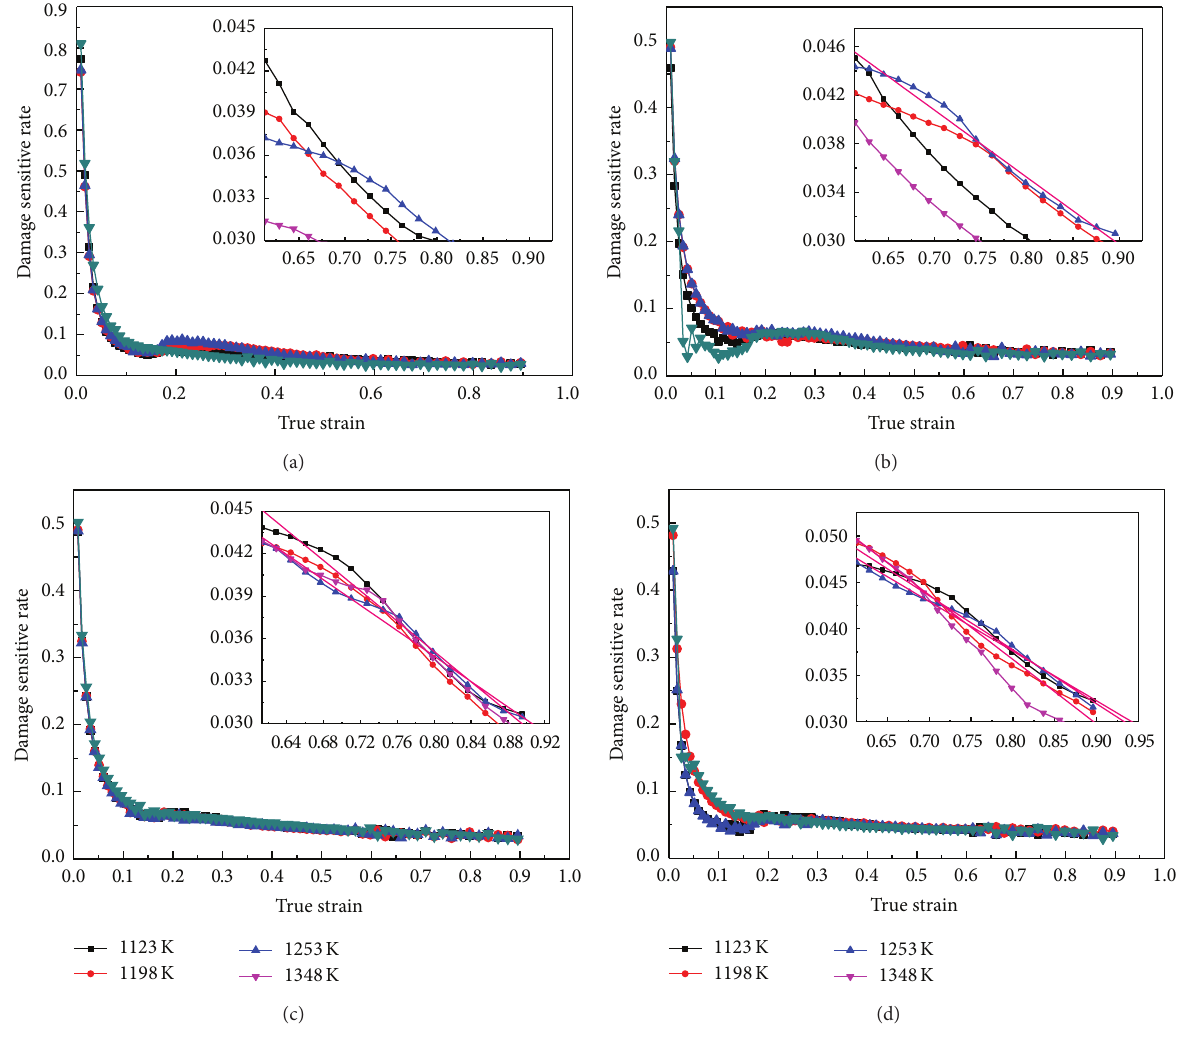
Figure 7: The variation of damage sensitive rate under different temperatures and strain rates: (a) 0.01s −1 , (b) 0.1 s −1 , (c) 1s −1 , and (d) 10 s −1 .